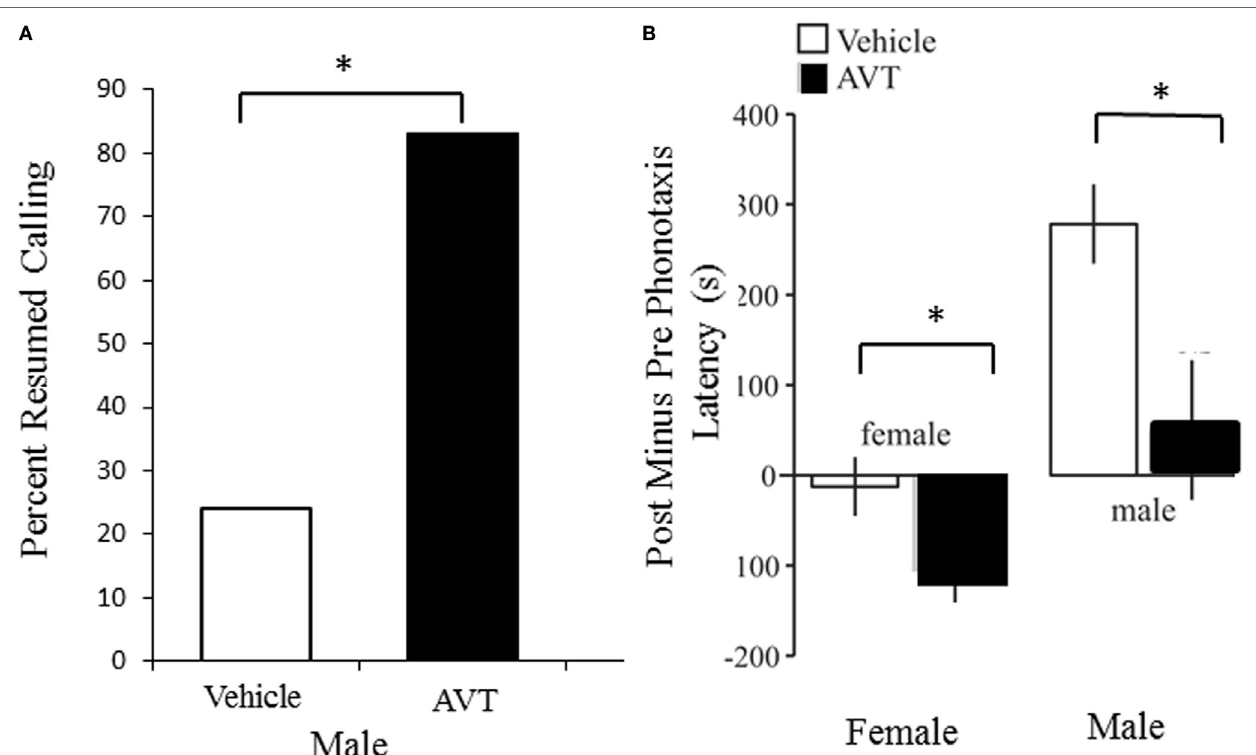
FiGURe 3 | Arginine vasotocin (AVT) modulates reproductive social behavior in both male and female túngara frogs. (A) . Treating males with 25 mg of AVT (IP injection; N = 18) significantly increases the probability that males will resume calling after treatment compared to saline vehicle injection ( N = 17). Data are from Kime et al. (69). (B) . Treatment with 25 mg of AVT (IP injection) decreases latency to choose and reach a speaker playing a conspecific male advertisement call in both females (left) and males (right), compared to saline vehicle injection. Data are expressed as the difference between pre and post injection latencies; N = 12 individuals of each sex per treatment. Note that saline injections themselves increased latency to respond in males, but AVT treatment mitigated this effect. Data are from results illustrated in Baugh and Ryan